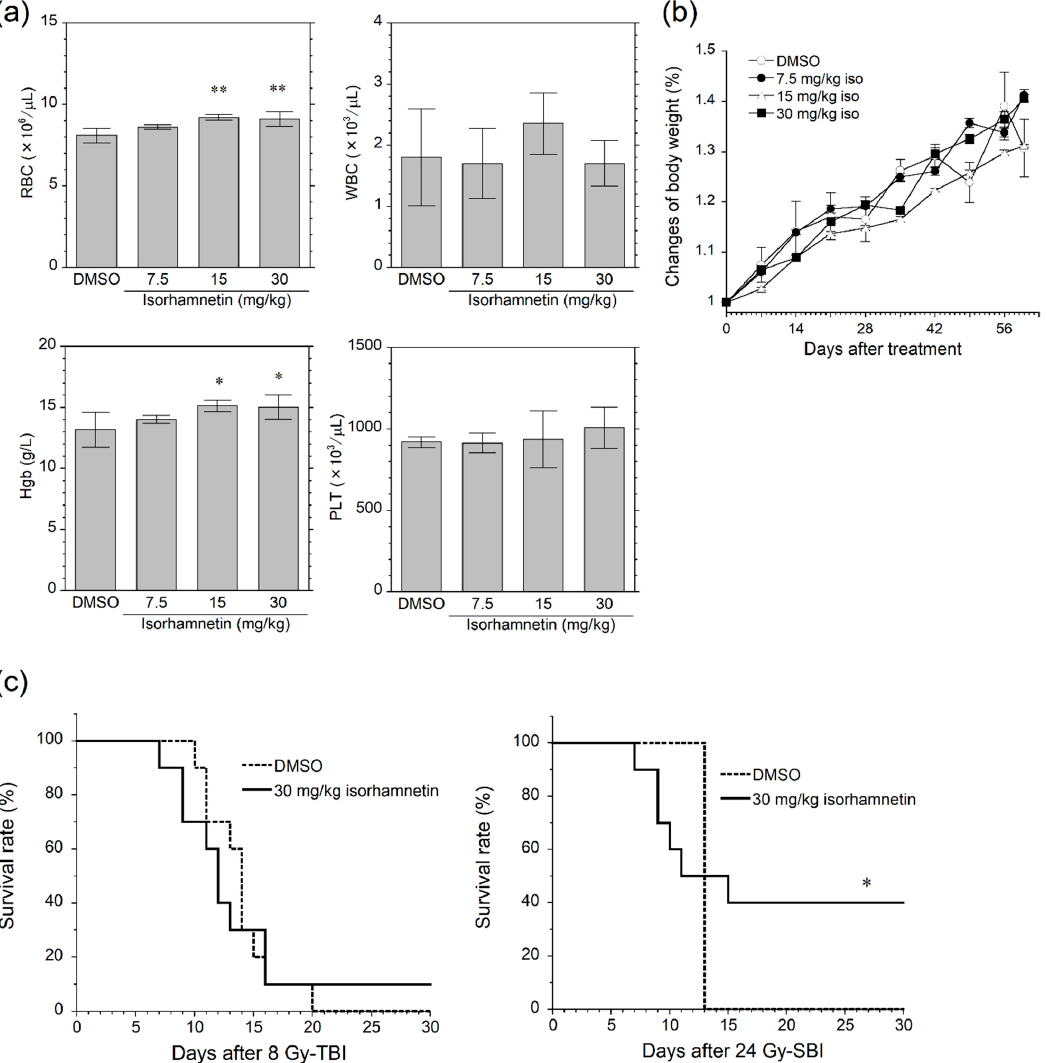
Figure 3. Isorhamnetin rescues mice from gastrointestinal death after SBI, but not from bone marrow death after TBI. ( a ) Hematological assay 61 days after single-dose of isorhamnetin ( n = 4 in each group). ( b ) Body weight changes after the isorhamnetin treatment ( n = 4 in each group). ( c ) 30-day survival tests after 8 Gy TBI and 24 Gy SBI ( n = 10 in each group). Data represent the mean ± standard deviation. Asterisks indicate a significant difference (* p < 0.05 and ** p < 0.01) between groups. DMSO dimethyl sulfoxide, Iso isorhamnetin, RBC red blood cells, Hgb hemoglobin, WBC white blood cells, PLT platelets, TBI total body irradiation, SBI subtotal body irradiation.